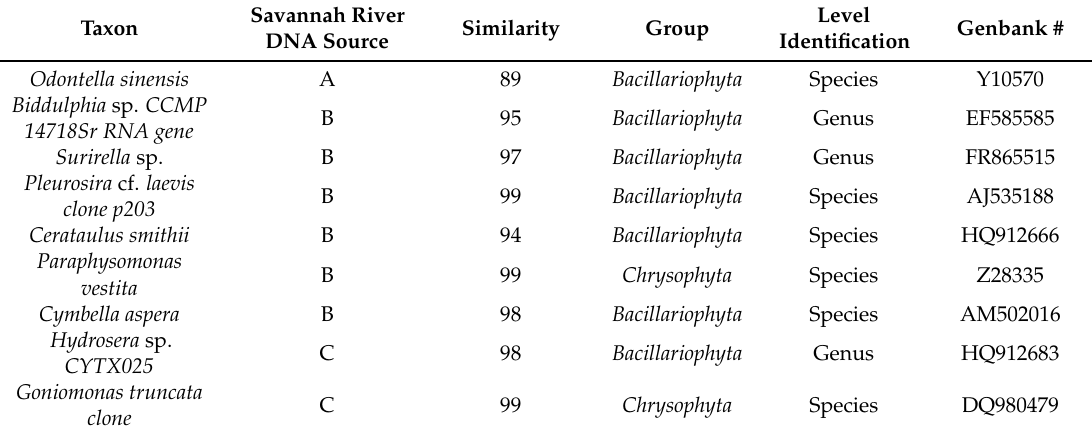
Table 1. List of algae identified via 18S rDNA sequence based BLAST search from the Genbank Clone sequence from A: Savannah River; B: Subculture samples of Savannah River on agar plates; and C: Subculture from Savannah River in liquid media.